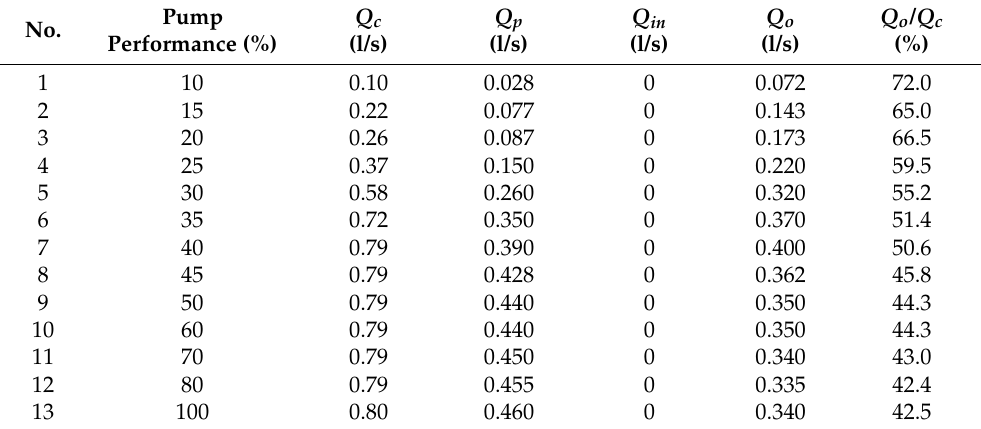
Table 8. Pilot test on the HJ-3 extraction well on 2 July 2020 (measured profile 11.75 m b.g.l.). No.